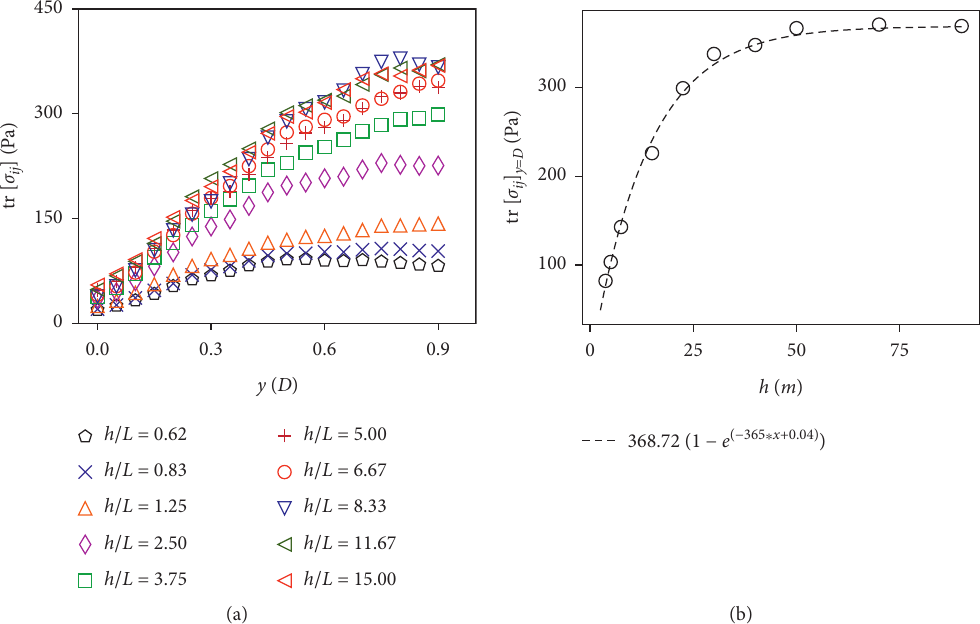
Figure 8: Results of contact pressure tr [ σ ] near the orifice. (a) Contact pressure tr [ σ ] at the vertical central line of the yellow box shown in ij ij Figure 2 against vertical position y normalized by the diameter of the outlet D for various heights h . (b) The contact pressure on the upper edge of the square shown as the yellow box in Figure 2 tr [ σ ij ]| y � D versus the particle bed height h .